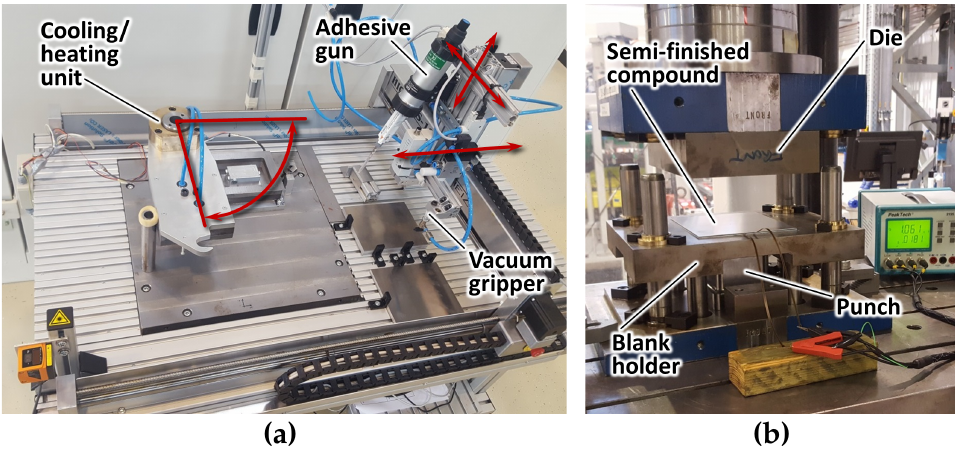
Figure 2. ( a ) automated fabrication unit (AFU) with rotatable upper and fixed lower cooling/heating unit on the left side and handling/application head with gripper and adhesive gun on the right side of the picture and ( b ) semi-finished compound before forming in the deep-drawing